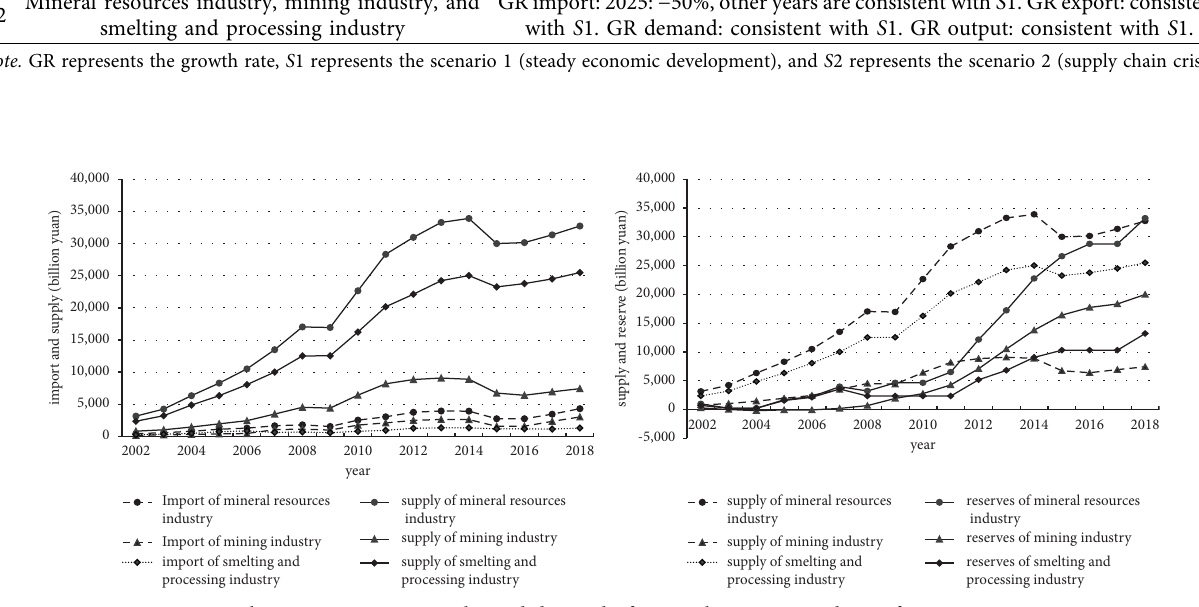
Figure 3: Changes in import, supply, and demand of mineral resources industry from 2002 to 2018.